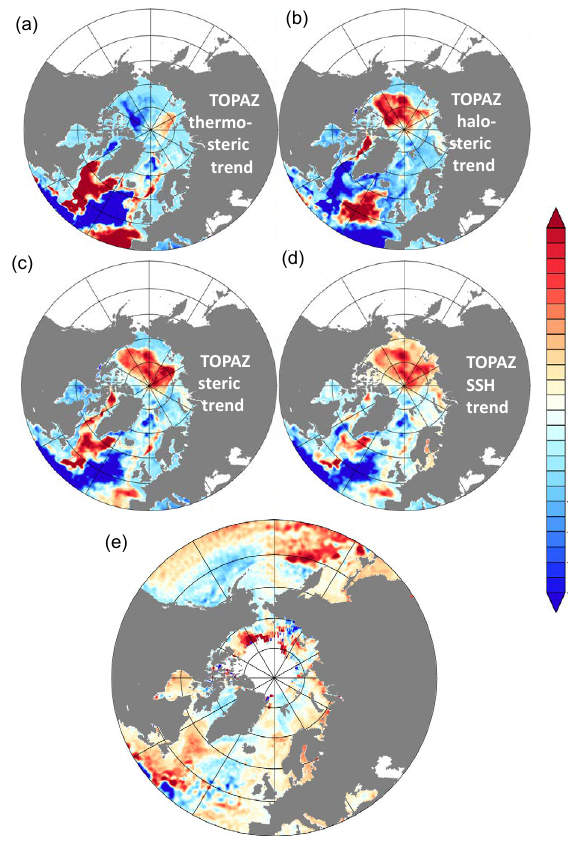
Figure 13. Contribution to the sea level trend (mmyr − 1 ) from TOPAZ4 reanalyses for the period 1993–2016 for (a) the ther- mosteric contribution, (b) the halosteric contribution, (c) the total steric trend and (d) the total trend. The observed trend from the ESA SL_cci v2.0 data (e)